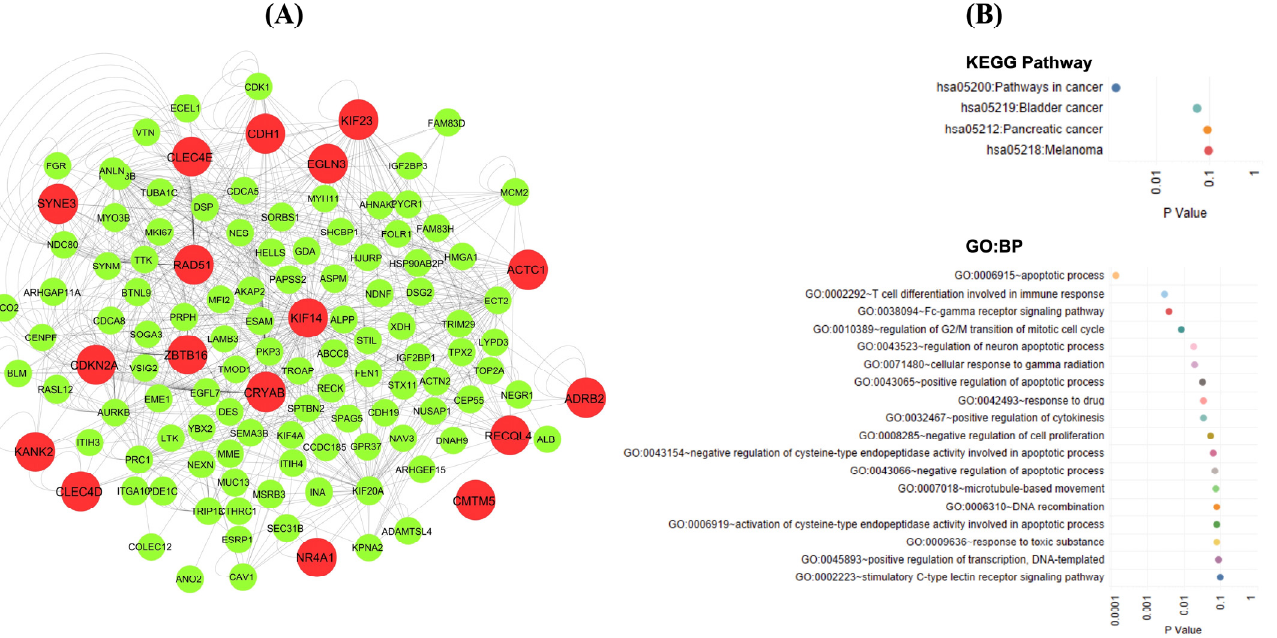
Figure 5. Sub-network of the signature genes and their functional enrichment identified through the LASSO. ( A ) Interaction network of genes identified through transcriptome–interactome signatures and their first neighbors. The genes are represented as red nodes, while their first neighbors are shown in green. ( B ) Functional enrichment analysis of 17 targets against the pathway database KEGG and biological process in the Gene Ontology database.